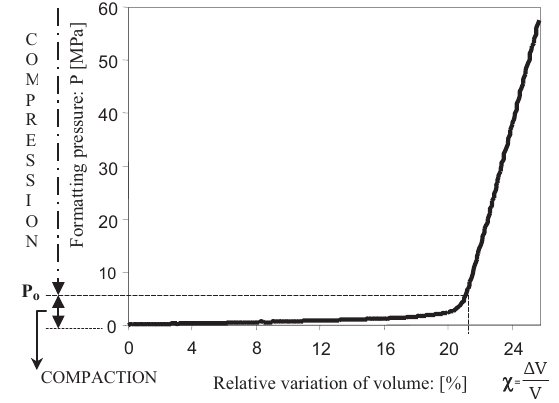
Fig. 1. Compaction curve of the clay paste: variation of the relative volume of the matrix in function of pressure.